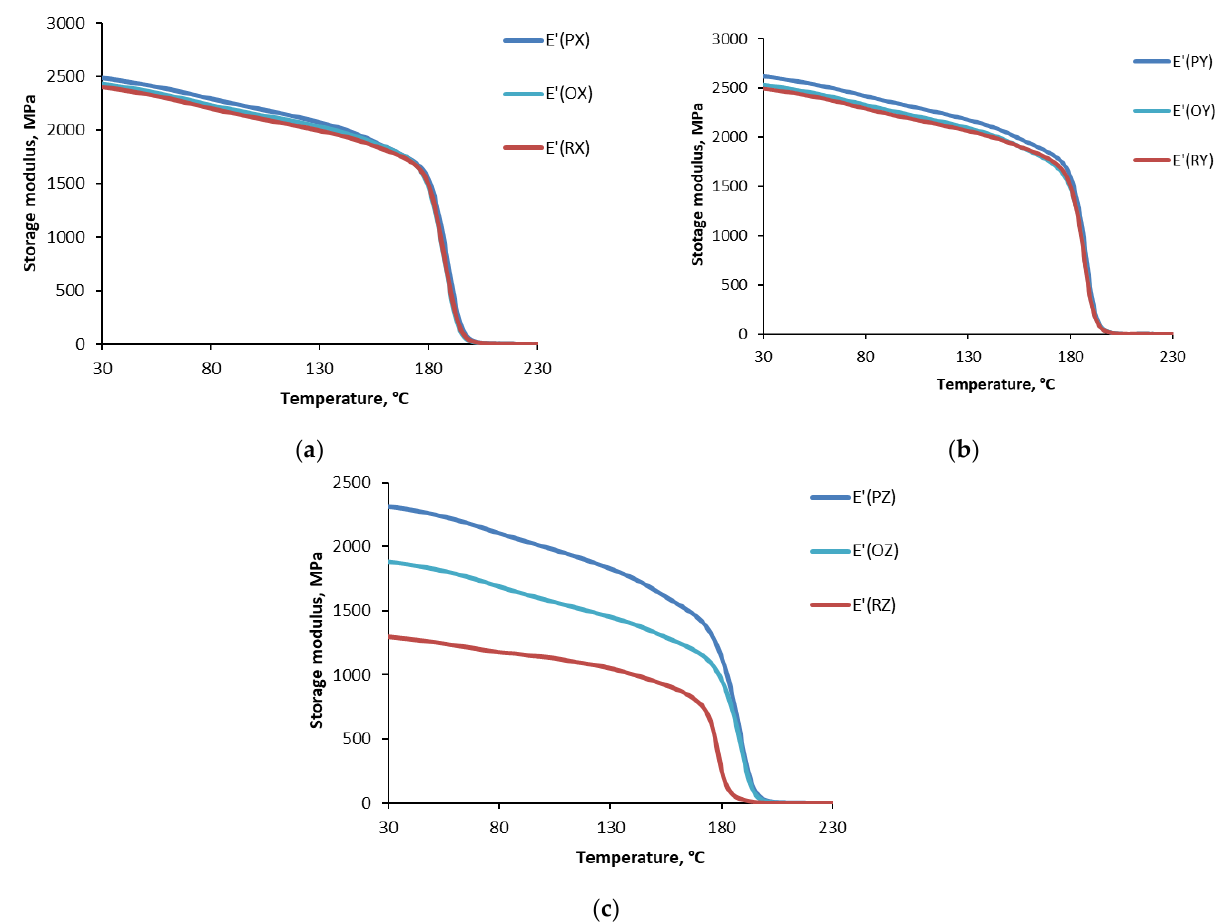
Figure 9. The storage modulus of Ultem samples vs. temperature printed in X ( a ), Y ( b ), and Z ( c ) directions. The cooling conditions (printer: P, oven: O, room temperature: R) are provided in the legend.